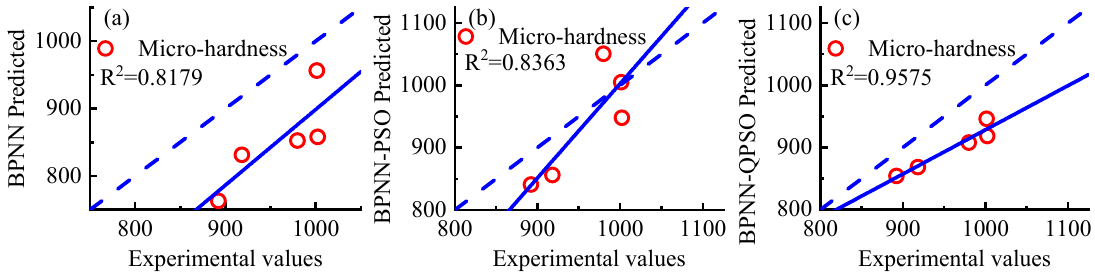
Figure 11. Comparison diagram predicted and experimental micro-hardness of coatings: ( a , b ) BPNN;